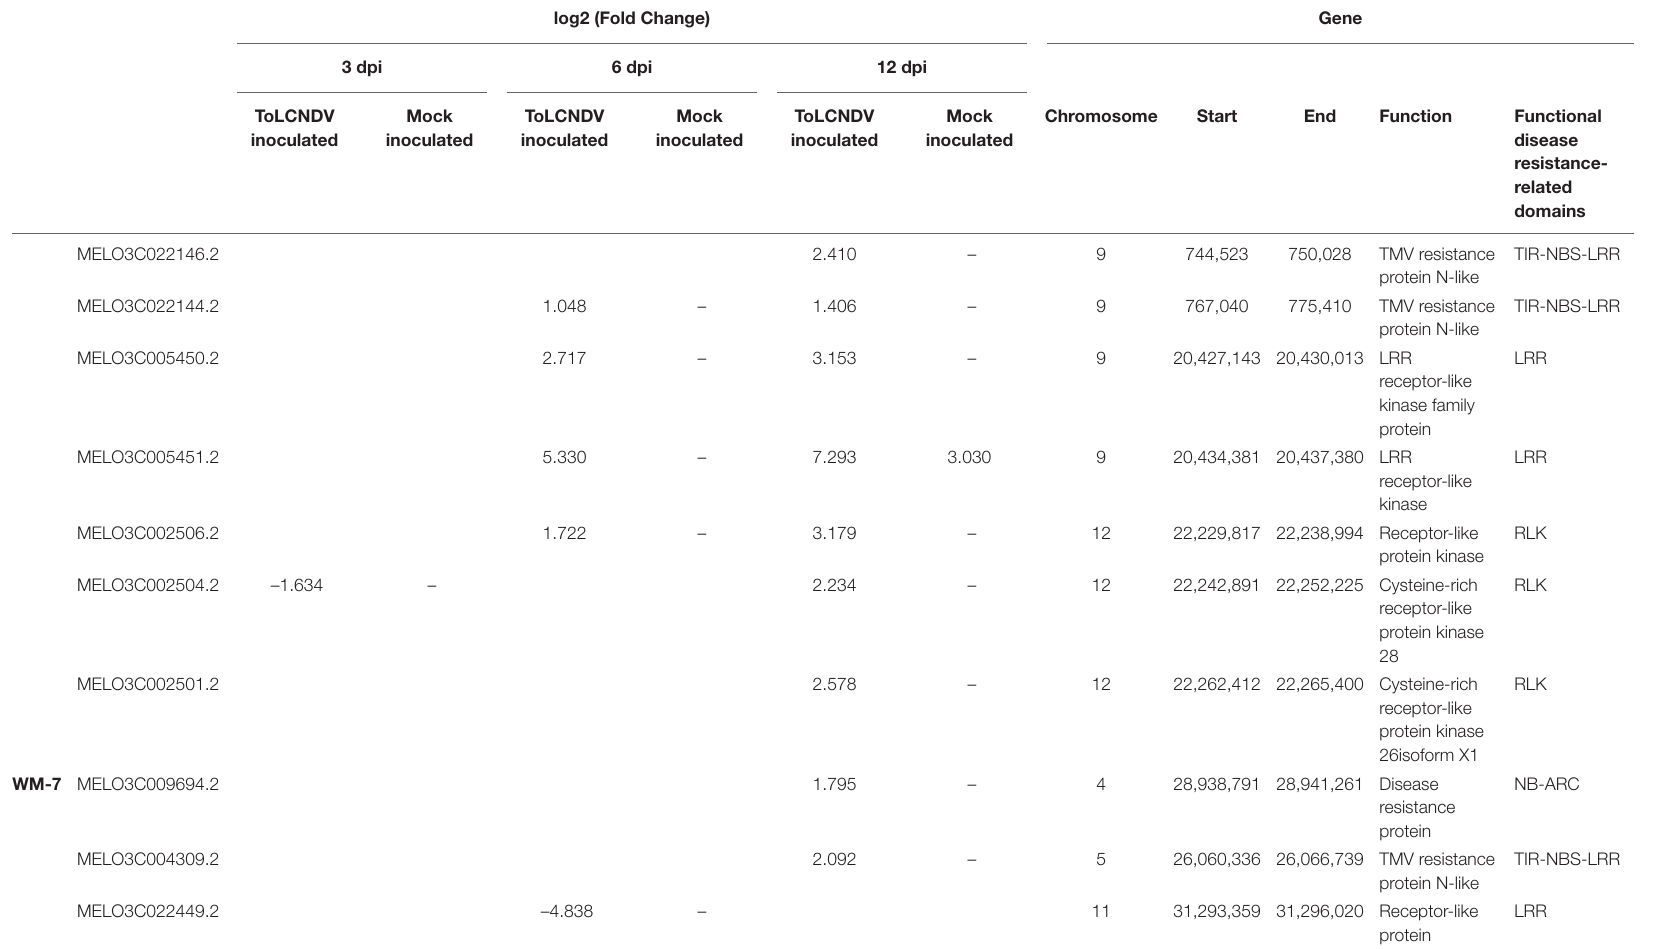
Expression pattern of each gene is presented as log2 (fold change) at 3, 6, and 12 dpi stages. Physical position of genes according to v4.0 of melon genome, functional annotation, and disease resistance–related domain are